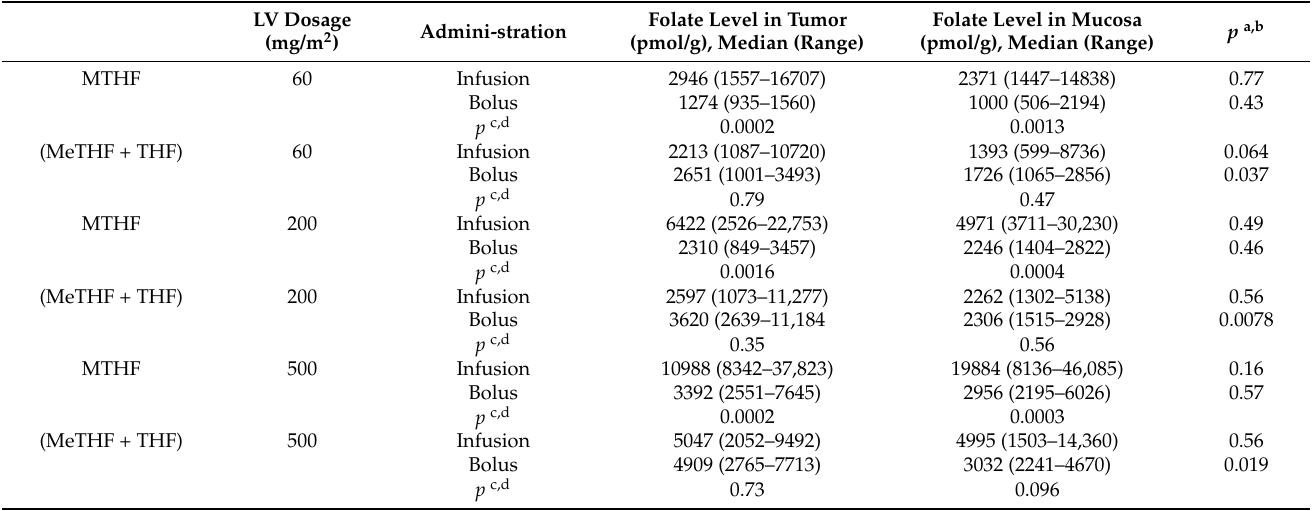
Table 2. Comparison of folate levels in tumor and mucosa of patients treated with two-hour infusion versus bolus injection of LV. Vertical p -values are reflecting infusion vs. bolus in each group. LV Dosage Folate Level in Tumor Folate Level in Mucosa Admini-stration p a,b (mg/m 2 ) (pmol/g), Median (Range) (pmol/g), Median (Range)